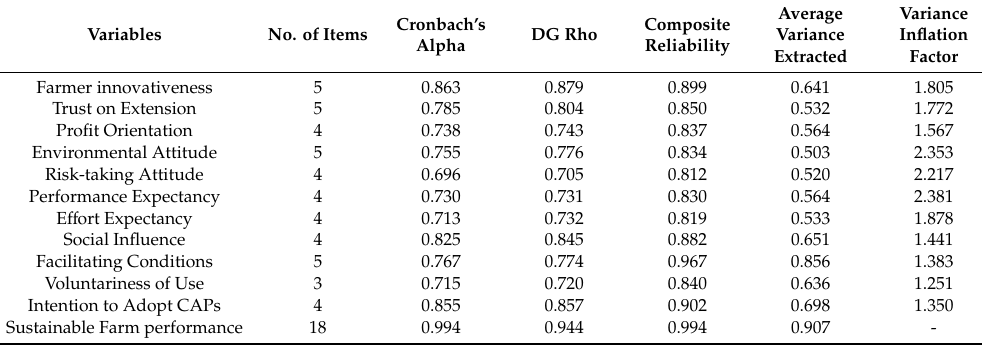
Table 2. Reliability